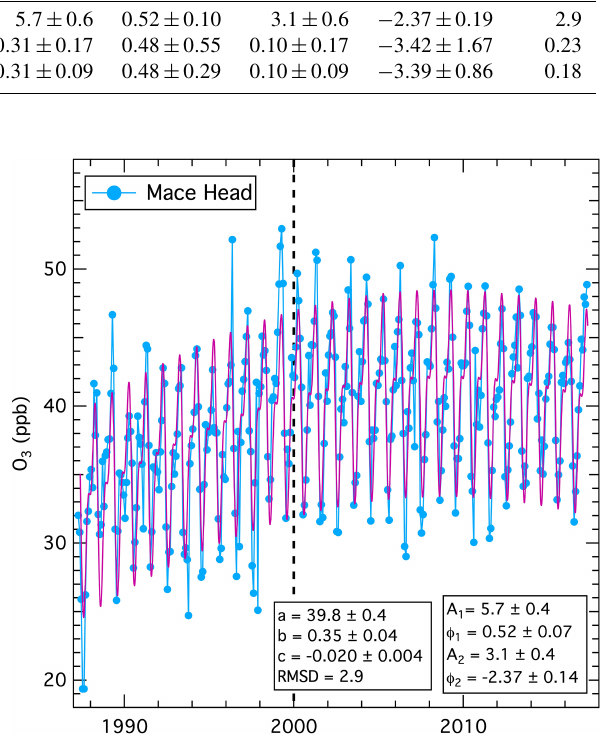
Figure 4. Results of the nonlinear regression fit of Eq. (4) (violet line) to the monthly mean concentrations from Fig. 1. Table 2 gives the units of the parameters, and the confidence limits corrected for autocorrelation in the data